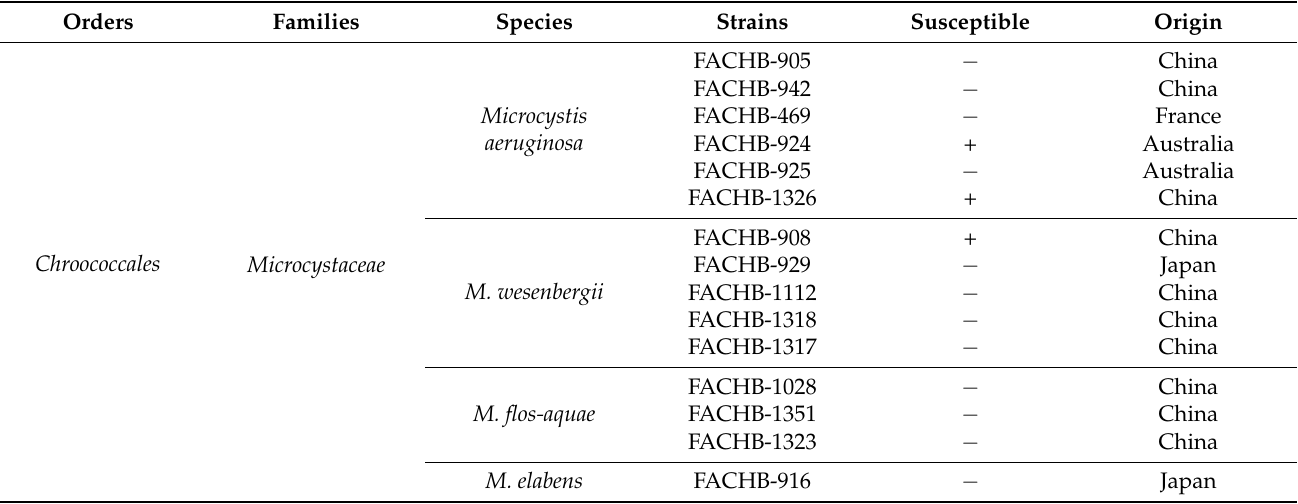
Table 1. Host range analysis of Mae-Yong1326-1 against 39 cyanobacteria